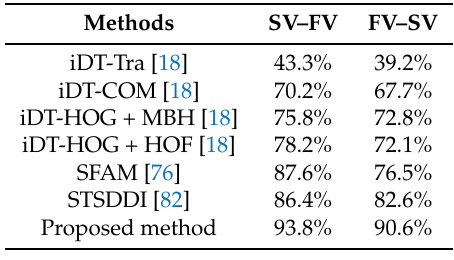
Table 11. Comparison of the proposed method with other methods on the M 2 I dataset for the cross-view scenario (SV–FV:training in the side view and test in the front view; FV–SV:training in the front view and testing in the side